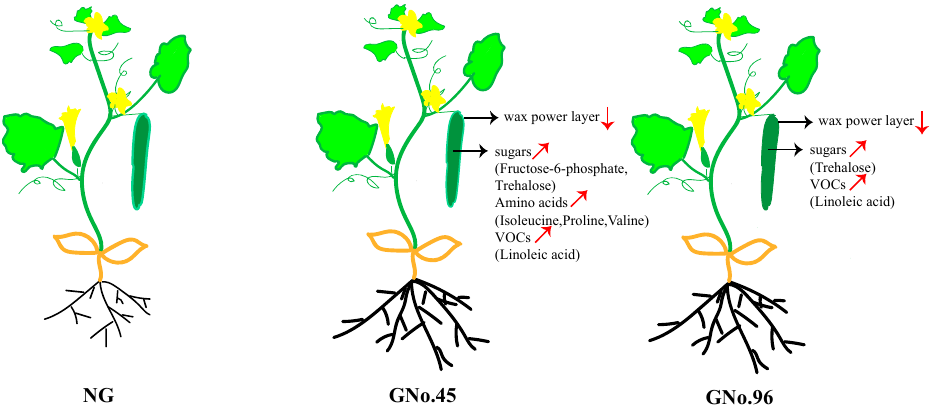
Figure 9. Summary of the differences in metabolites contributing to cucumber flavor in NG, GNo.45, and GNo.96 .